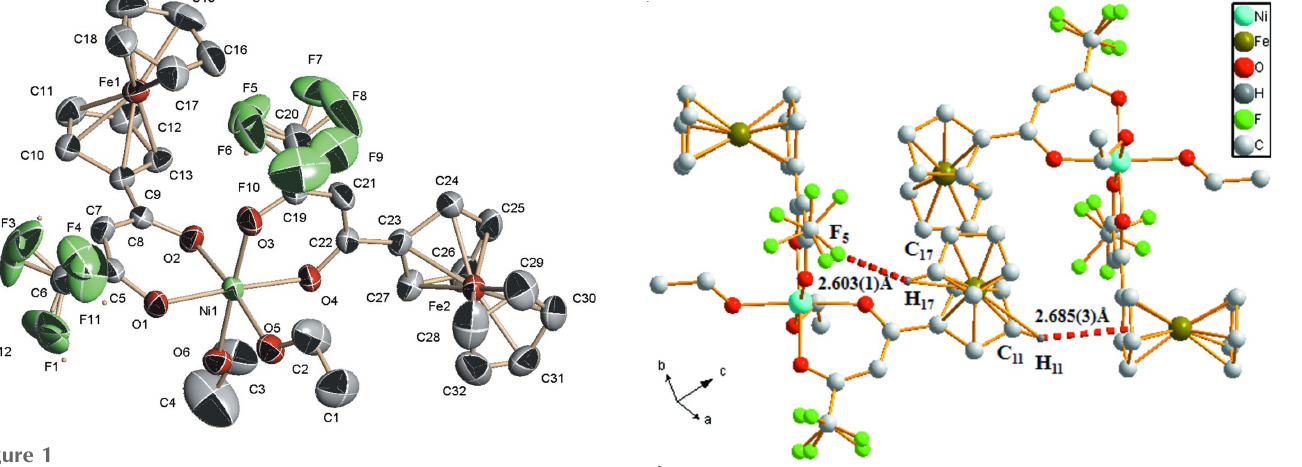
Figure 2 Part of the crystal structure of the title compound, showing some intermolecular interactions.